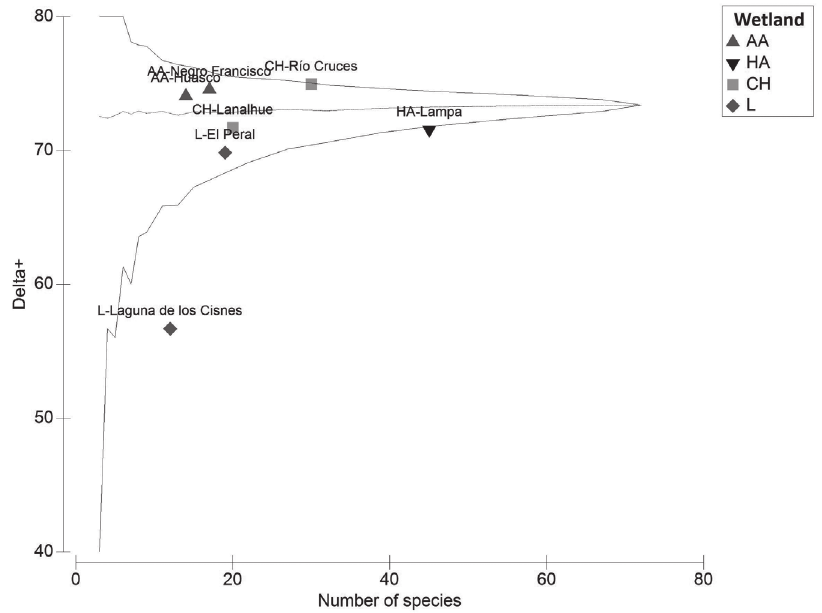
Figure 3. Funnel plot of the mean taxonomic distinctiveness (Δ+) of seven inland wetlands in Chile. AA= High-Andean wetlands (Huasco and Negro Francisco), HA= man-made wetland (Tranque San Ra- fael), CH= wetland complexes (Lago Lanalhue and Río Cruces), L= Lagoon (El Peral, Los Cisnes). Ex- presses 95% confidence